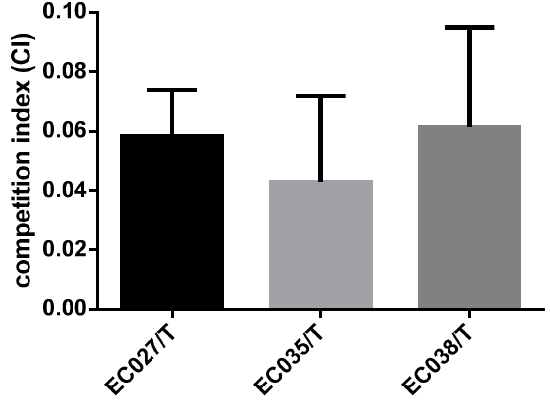
Figure 5. The competitive index of extracorporeal